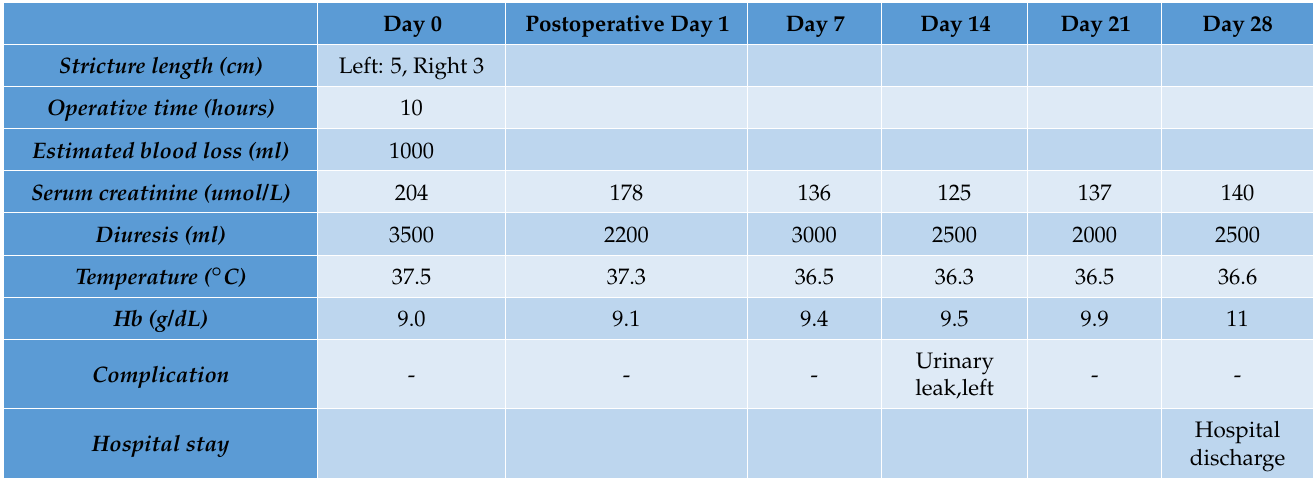
Table 1. Perioperative patient